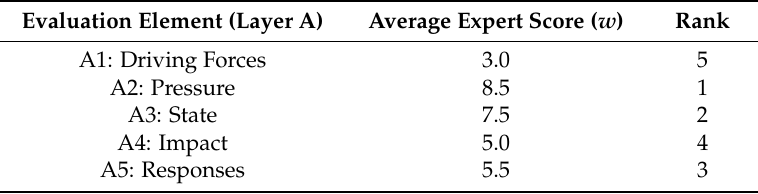
Table 2. Weights and rank of the evaluation elements